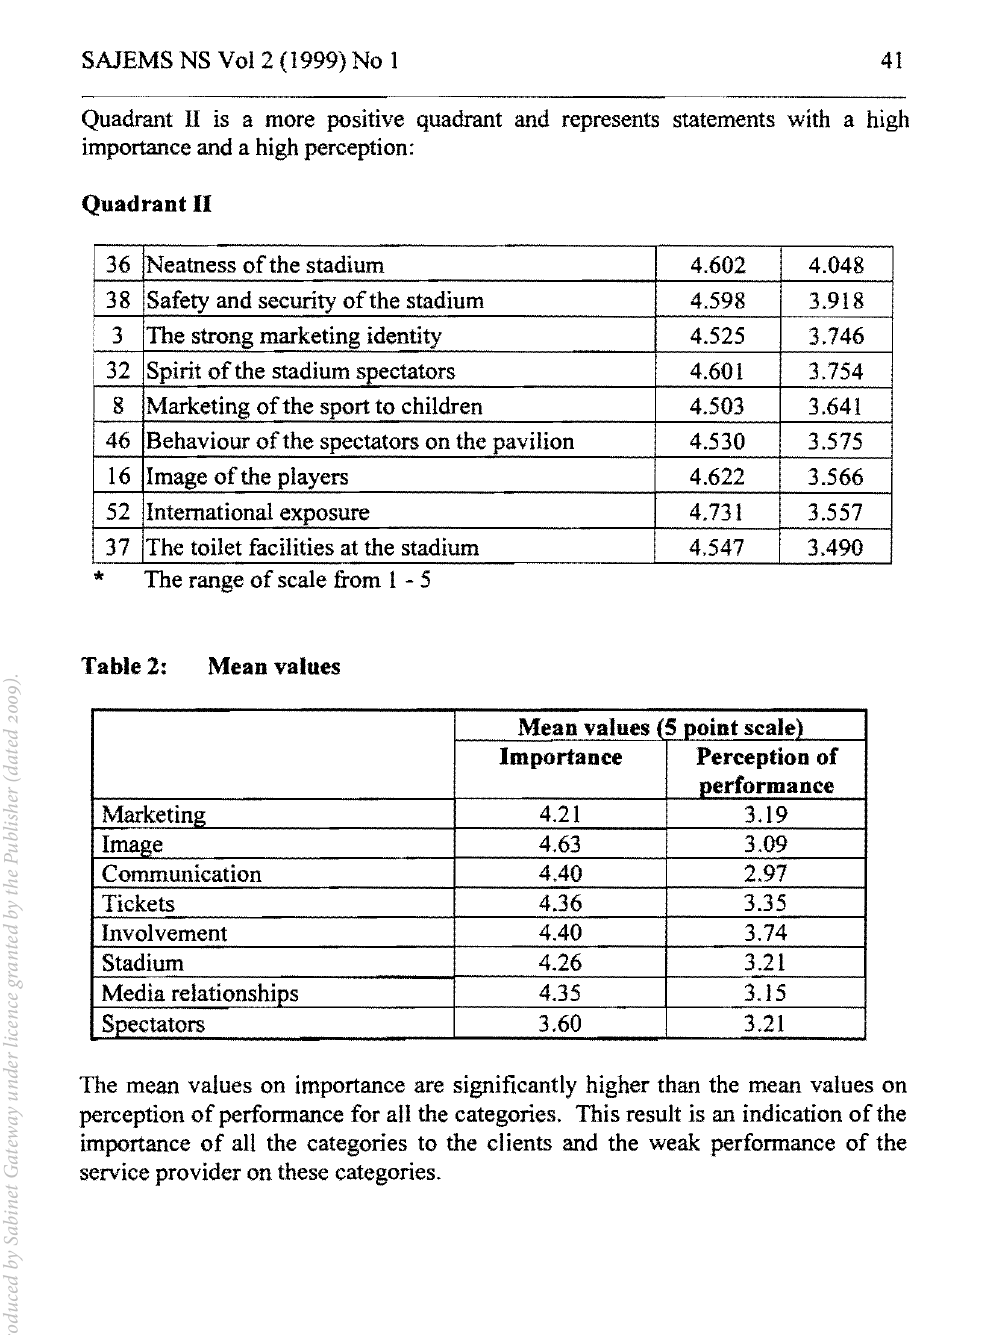
Mean values (5 point